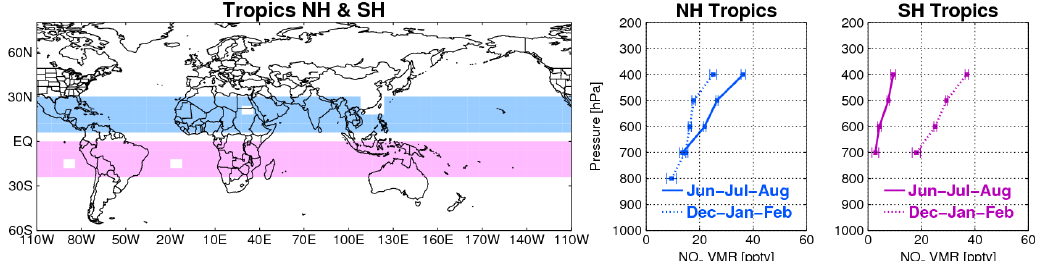
Figure 8. Left: sampling areas for profiles over tropics of NH (blue) and SH (purple); center: NO 2 profiles over NH tropics for June–August (blue solid line) and December–February (blue dotted line) with standard errors; right: NO 2 profiles over SH tropics for June–August (purple solid line) and December–February (purple dotted line) for